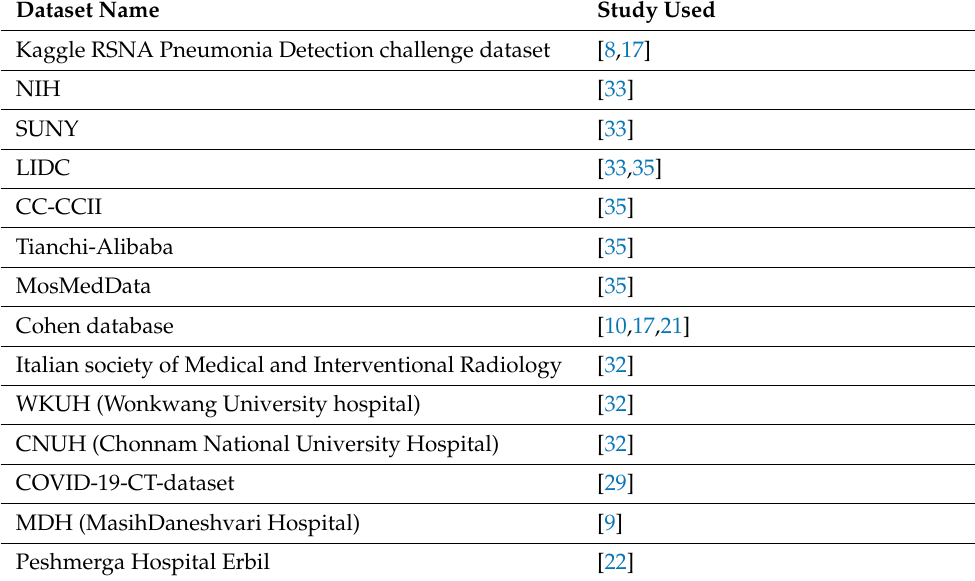
Table 5. The share of datasets amongst studies.